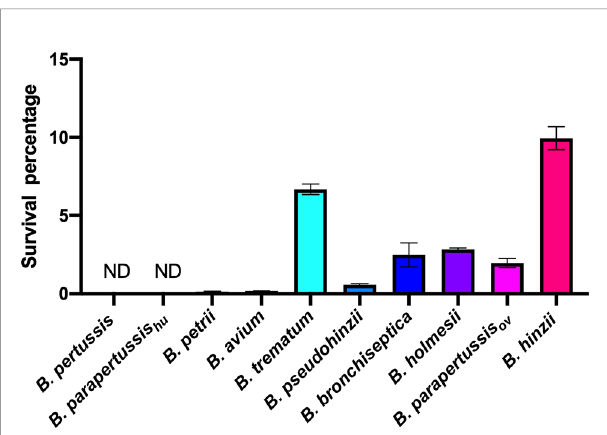
FIGURE 4 | Different intracellular survival ratios observed within non-classical Bordetella species. Intracellular survival of Bordetella species inside vegetative amoebae was assessed in a 2-hour gentamicin protection assay using an MOI at 1. In this assay, various non-classical Bordetella species were tested, including B. petrii , B. avium , B. trematum , B. pseudohinzii , B. holmesii and B. hinzii . Error bars show the standard error of mean (n=3). ND, none detected.